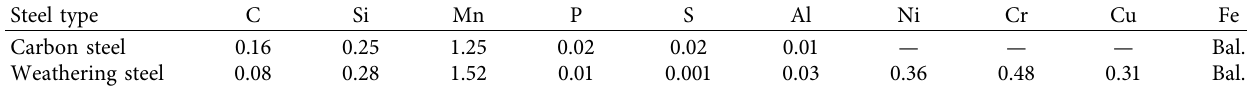
Table 1: Chemical composition of steel specimen (wt%).